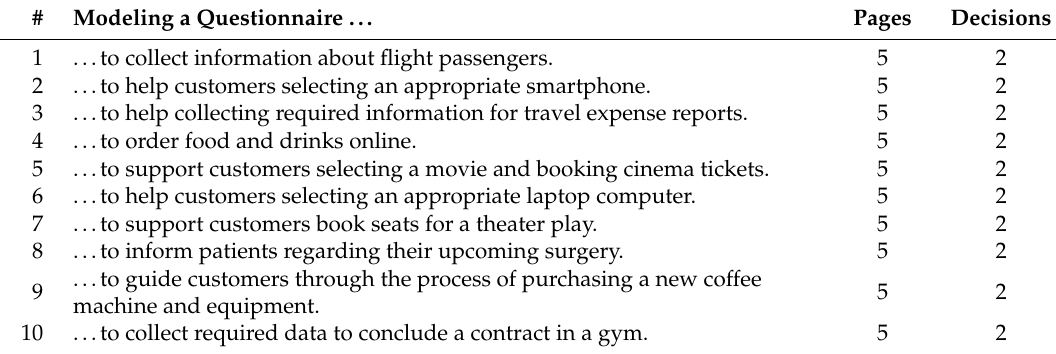
Table 2. Short description of tasks to be modeled by